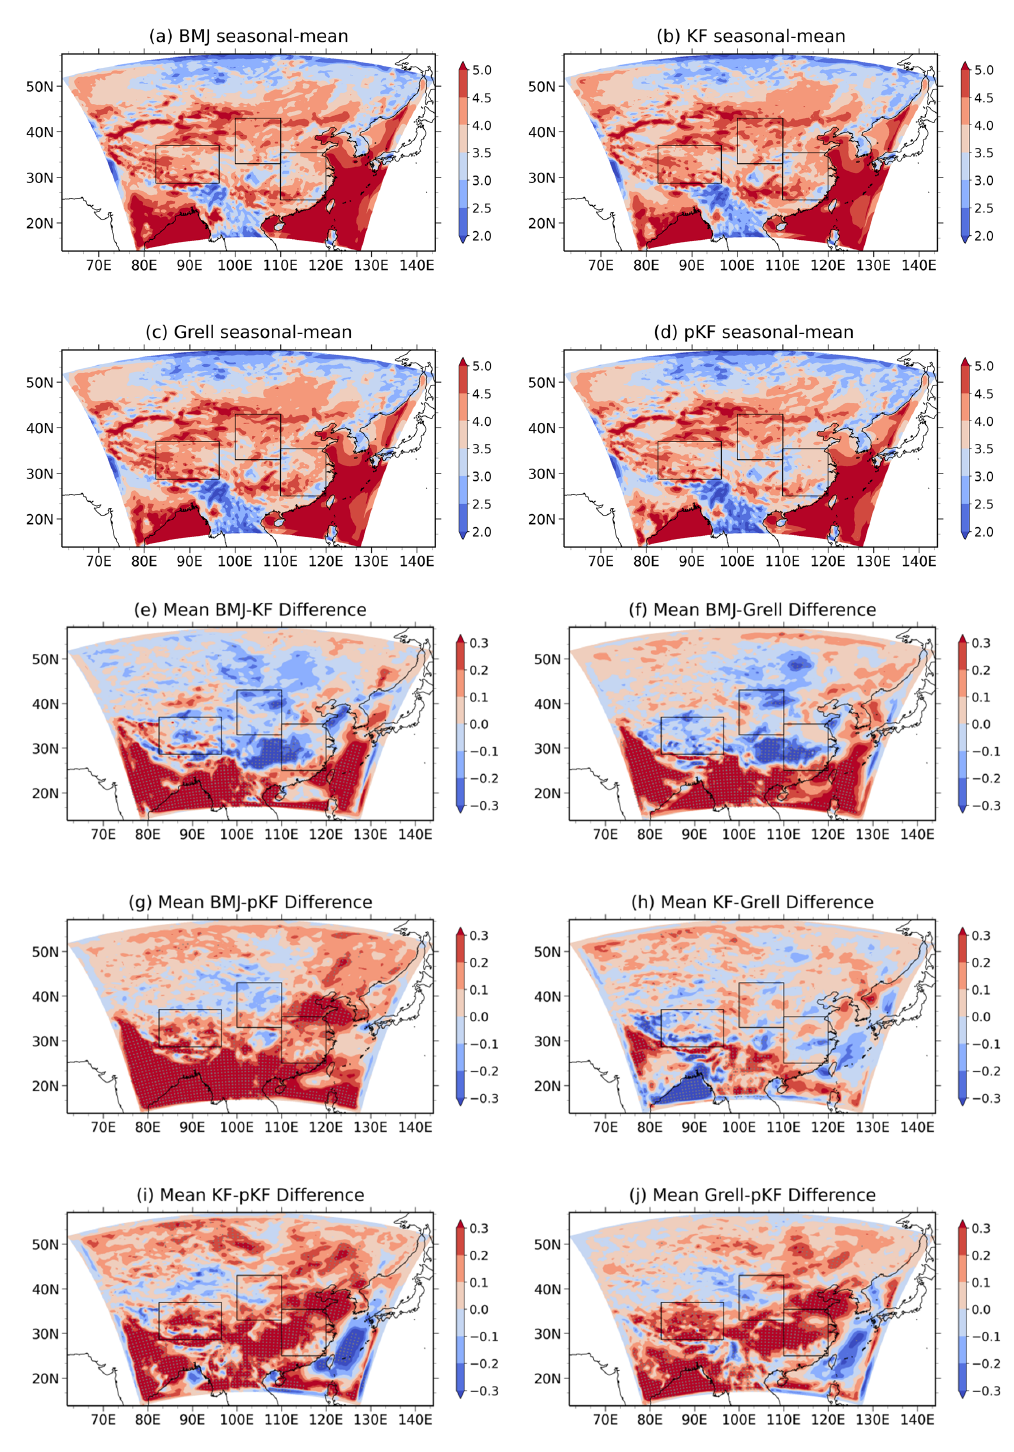
Figure 2. Ensemble mean seasonal spatial distributions of the 10 m wind speed in the CPS simulations (units: m s − 1 ), where grid cells are marked with grey dots for significant differences at the 0.10 significance level. Table 1. Ensemble seasonal mean correlation coefficients (CR MO ) for Northwest China (NW), East China (EC), the Tibetan Plateau (TP), and the land portion of the model domain (ALL).